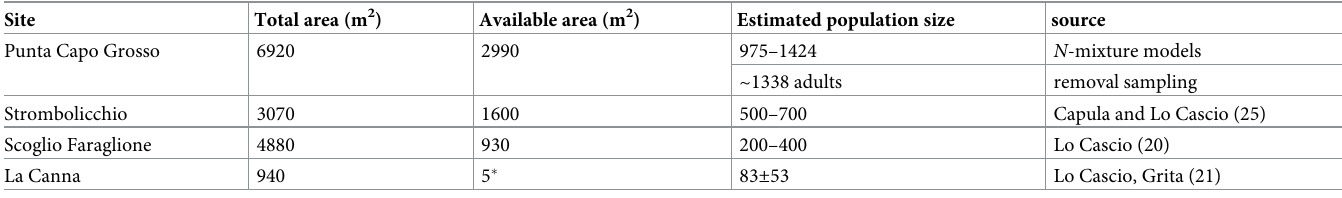
Table 1. Extent of occurrence and size of populations of Podarcis raffonei